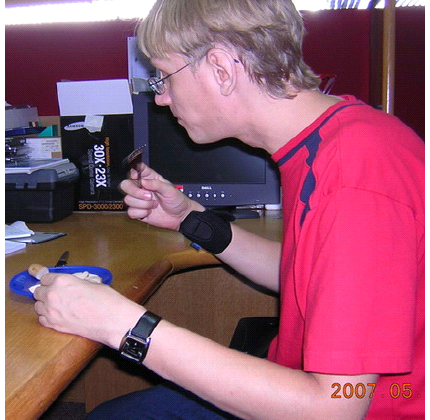
Figure 6. The eating detection